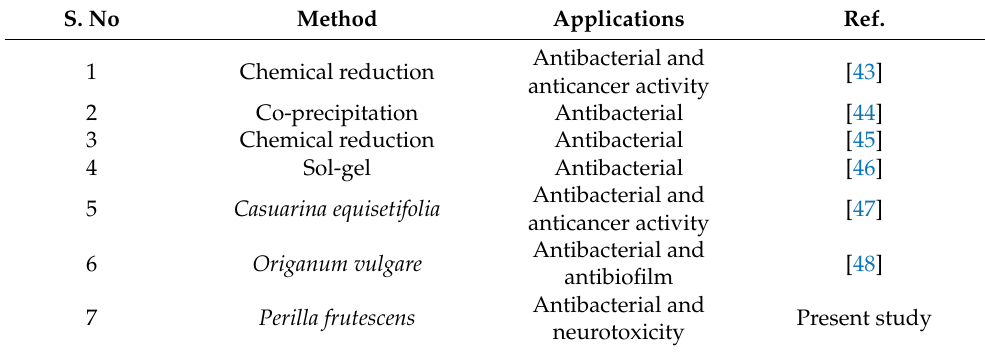
Table 2. Comparison of chemical and green synthesis of N-ZnO